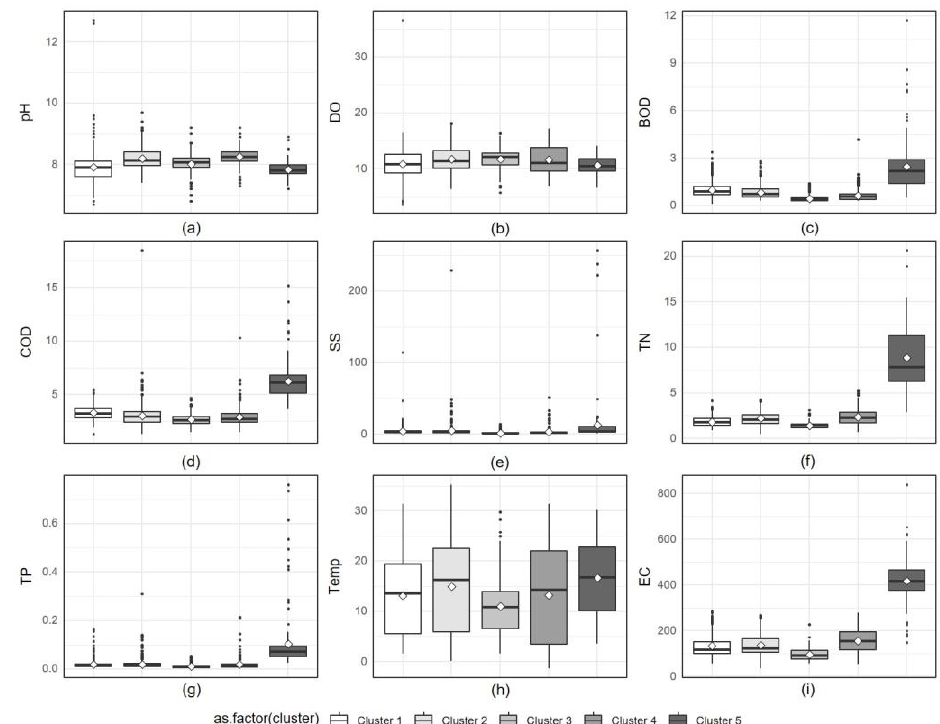
Figure 6. Cluster-specific boxplots for each variable when using the Euclidean algorithm about ( a ) pH, ( b ) DO, ( c ) BOD, ( d ) COD, ( e ) SS, ( f ) TN, ( g ) TP, ( h ) Temp, and ( i ) EC.